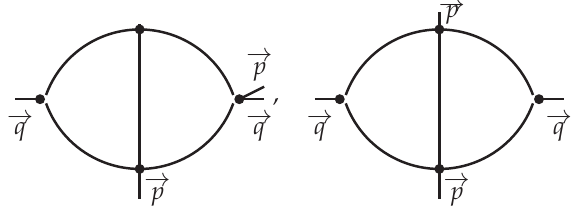
Figure 2. Most simplest diagrams: J 1 ( α = 1, q , p ) and J 2 ( α = 1, q , p )